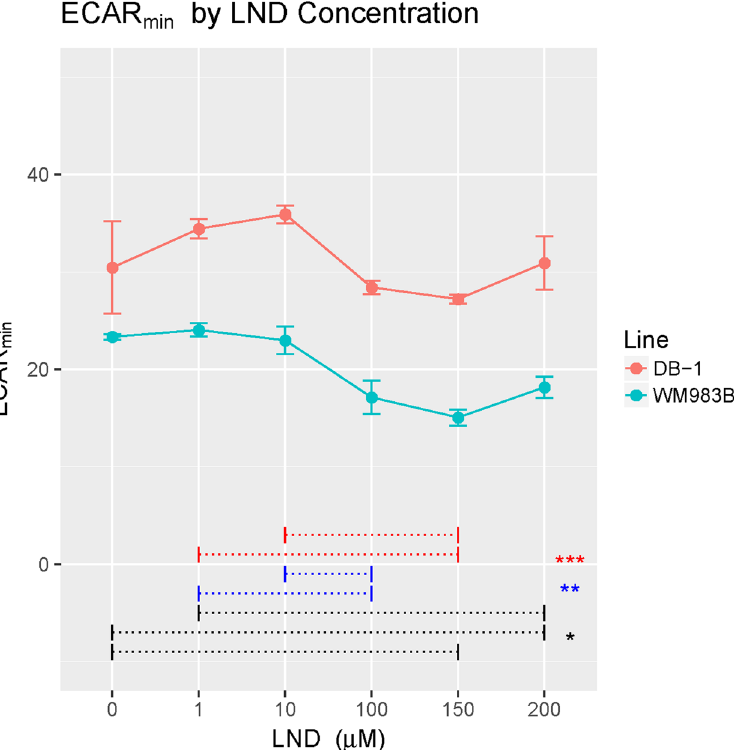
Figure 3. Lonidamine (LND) induces a concentration-dependent acute inhibition of extracellular acidification in DB-1 and WM983B human melanoma cells. We show ECAR min the lowest measured extracellular acidification rate within the first 60 minutes of LND treatment, against LND concentration (in µ M). ECAR min for DB-1 was significantly larger than for WM983B (p < 0.001 F 1,34 = 145) and there were significant effects as well for LND concentration (p < 0.001, F 5,34 = 9.2). Dotted lines connect LND concentrations of either 0, 1 or 10 uM with higher concentrations where there were significantly different mean levels of ECAR min .